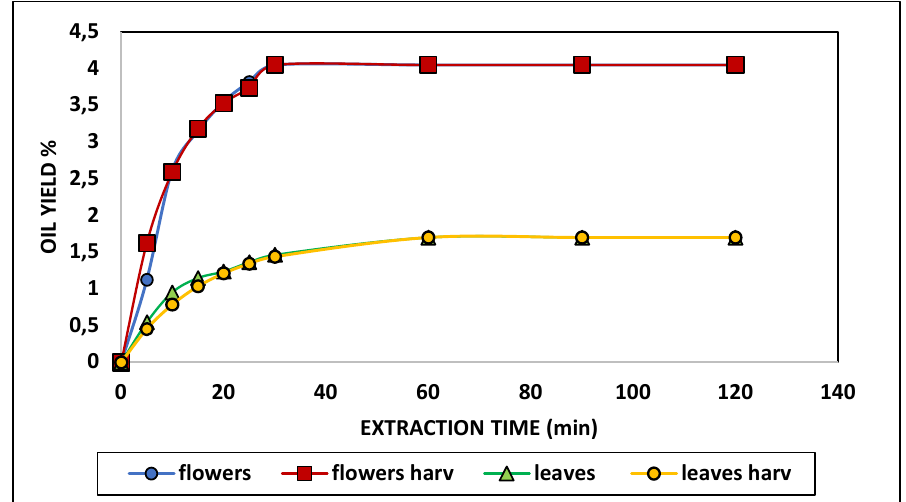
Figure 6. Yield curve of leaves and flowers essential oil of M. pulegium by hydro-distillation using Clevenger apparatus: mathematical model and experimental data